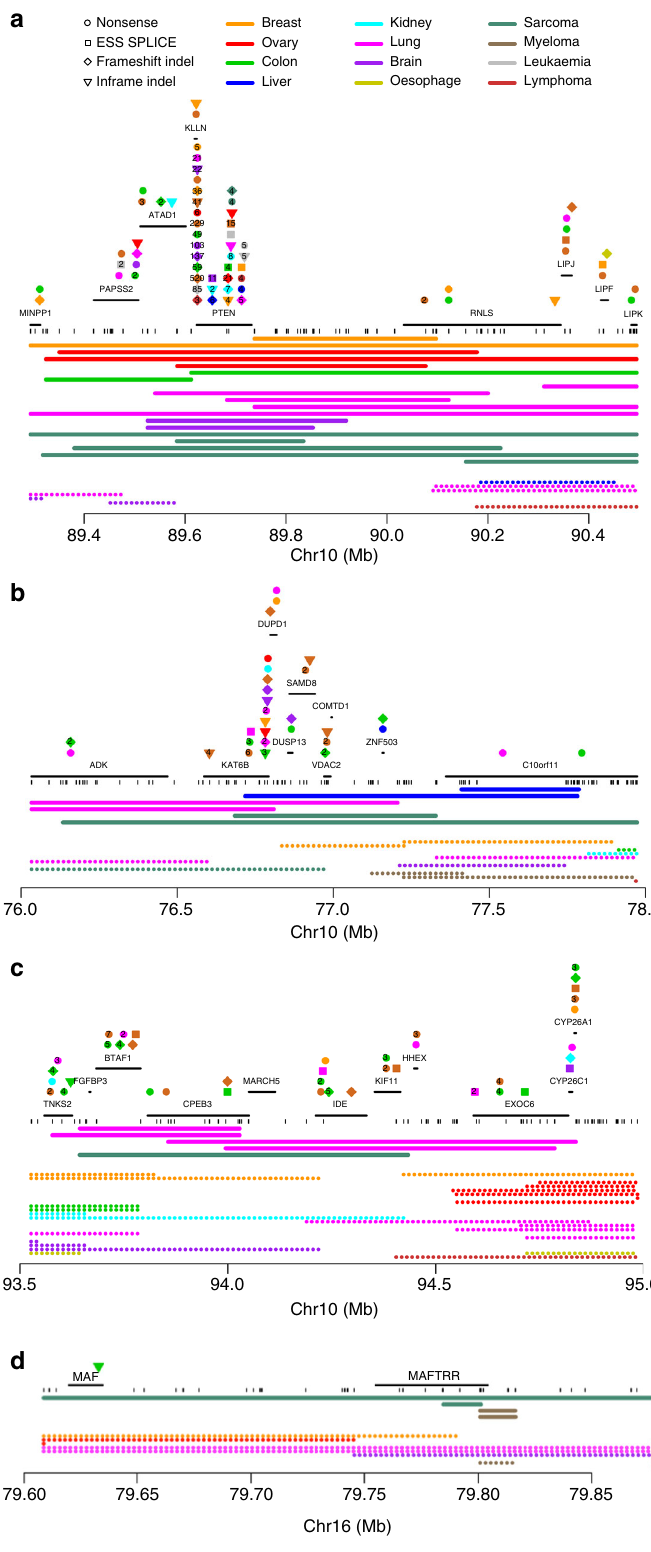
Fig. 6 Examples of tumour suppressors targeted by homozygous deletions. a Known tumour suppressor PTEN ; b – d candidate tumour suppressors identi fi ed in this study. b KAT6B , c CPEB3 , and d MAFTRR . Positions of genes are indicated as well as truncating mutations annotated in COSMIC 25 , coloured according to tumour type and with symbols showing the mutation type. When multiple somatic mutations in the same tumour type are annotated close together in COSMIC, their numbers are shown. Array probe positions are depicted below the genes. The minimal regions of homozygous deletions are shown as bold lines and small hemizygous deletions as dotted lines, both colour-coded by tumour type. Homozygous deletions are unlikely to extend more than two array probe positions beyond the indicated segments ( p = 0.015, see